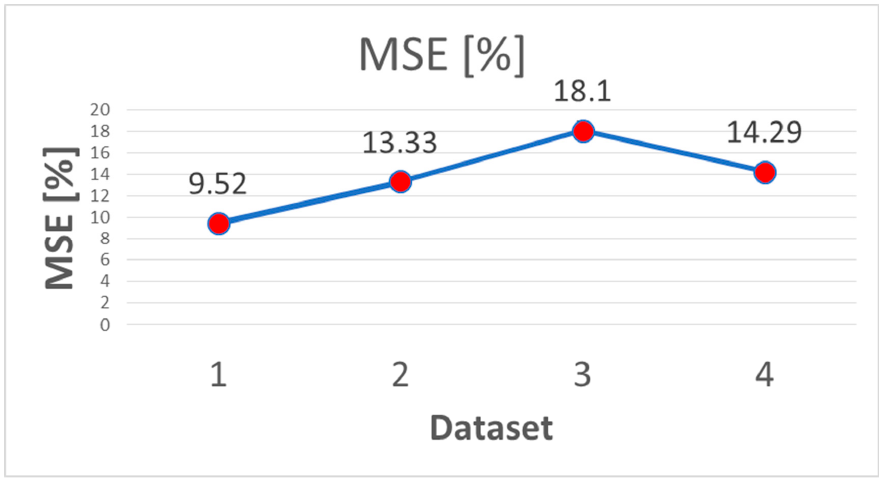
Figure 3. Experimental results using 4 different training dataset and comparison of recognition Mean Square Error (MSE). Table 4 shows the prediction accuracy P (mean ± SD), with sensitivity and specificity (mean ± SD) values, related to the nine ANN architectures only for dataset 1, that turned out to be the best set of predictive feature for seizure outcome. Table 4. This table shows the performance values of nine ANNs architectures. Highlighted in red, the one with the best classification performance (II) of 73.3 %. Architecture